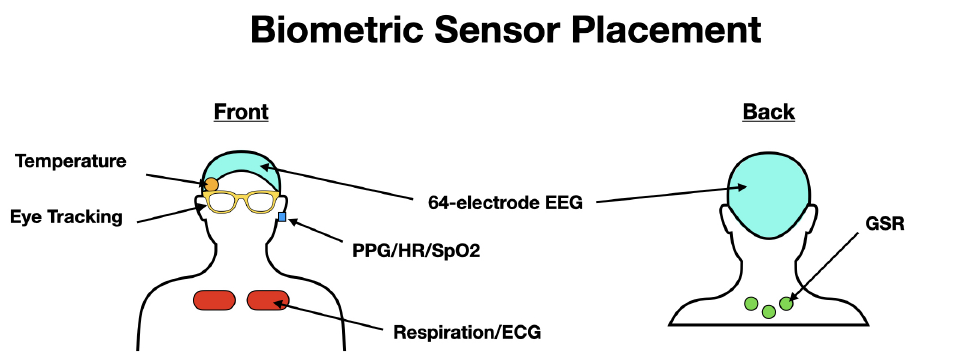
Figure 3. Schematic of biometric sensor placement on participant. ( Left ) Cartoon of front participant view. The 64-electrode EEG sits on the participant’s head. A temperature probe is placed under the EEG cap on the right temple. Eye tracking glasses are carefully placed on participant, avoiding EEG electrodes. PPG sensor is secured to left ear lobe. Respiration sensors are place near the top of the chest. ( Right ) Cartoon of back participant view. GSR sensors are placed below the back of the